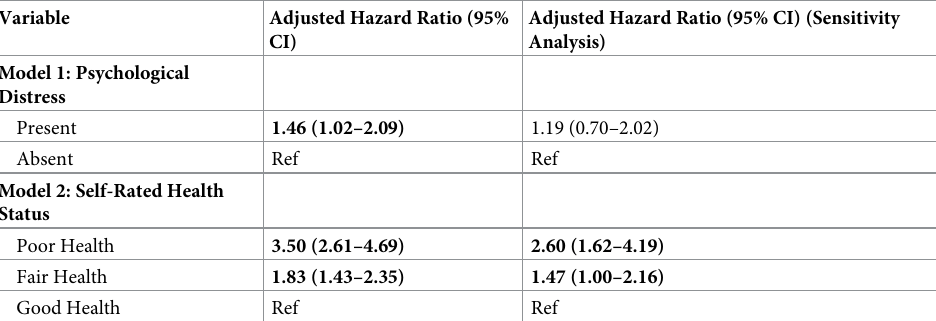
Table 3. Adjusted hazard ratio of the effect of psychological distress and self-rated health on time to death among women aged 30–64 years diagnosed with breast cancer (N = 2,817) and a sensitivity analysis on those diagnosed five years or less from the time of the survey (N = 1,395).